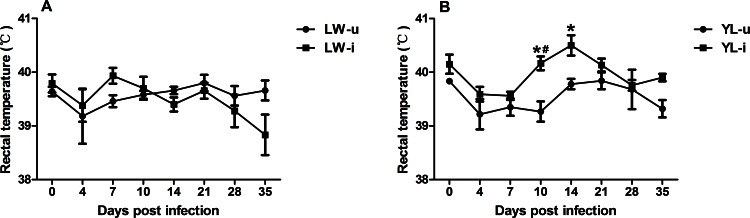
Changes in rectal temperature after PCV2 infection.The rectal temperature of LW-u pigs (A), LW-i pigs (A), YL-u pigs (B) and YL-i pigs (B) were collected at different dpi. The rectal temperature of YL-i pigs exceeded 40°C from 10 to 21dpi. * P < 0.05 versus YL-u group at same dpi, # P < 0.05 versus YL-i group at 7dpi.